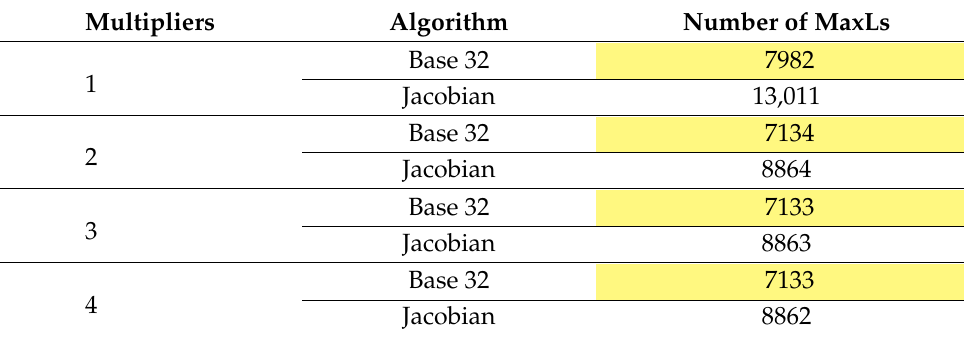
Table 9. Maximum Levels at Different Numbers of Multipliers.